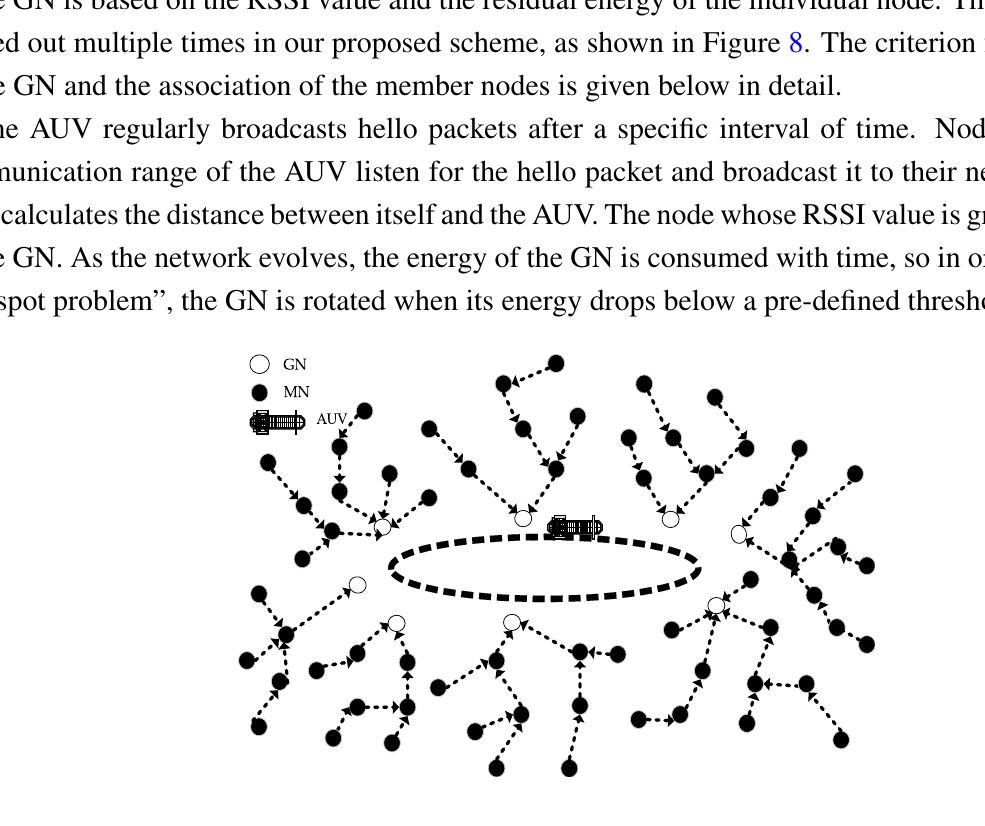
Figure 9. Association of member nodes with the GN through the SPT and communication between the GN and the